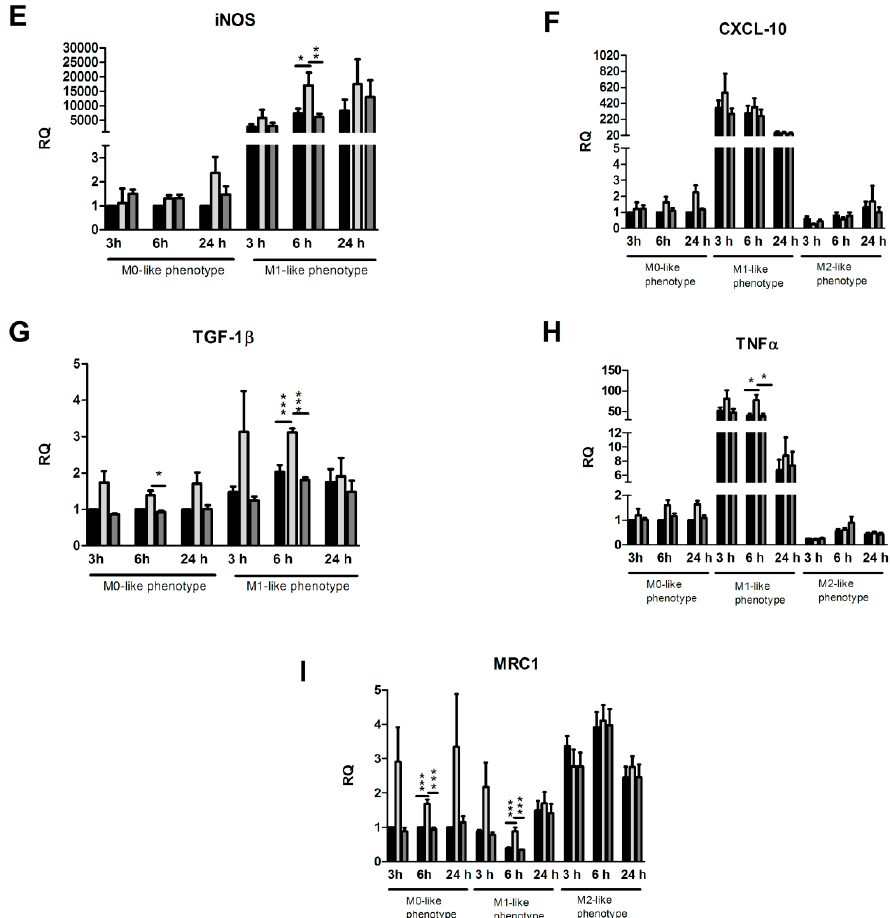
Figure 2. Effects of DMF and MMF on gene expression in microglia. Microglia were treated with medium, 10 µ M DMF or 10 µ M MMF for 24 h and afterwards stimulated with LPS (100 ng/mL) or IL-4 (20 ng/mL) for another 3, 6 or 24 h. Graphs show mRNA expression fold changes of IL-10 ( A ), IL-1 β ( B ), CCL3 ( C ), IGF-1 ( D ), iNOS ( E ), CXCL-10 ( F ), TGF1- β ( G ), TNF α ( H ) and MRC1 ( I ), calculated for untreated and unstimulated cells, normalized with HPRT-1 and using the ∆∆ CT method. Data are presented as the arithmetic means ± SEM of n = 4–6. Significant differences are marked by asterisks (* p < 0.05; ** p < 0.01; *** p < 0.001).